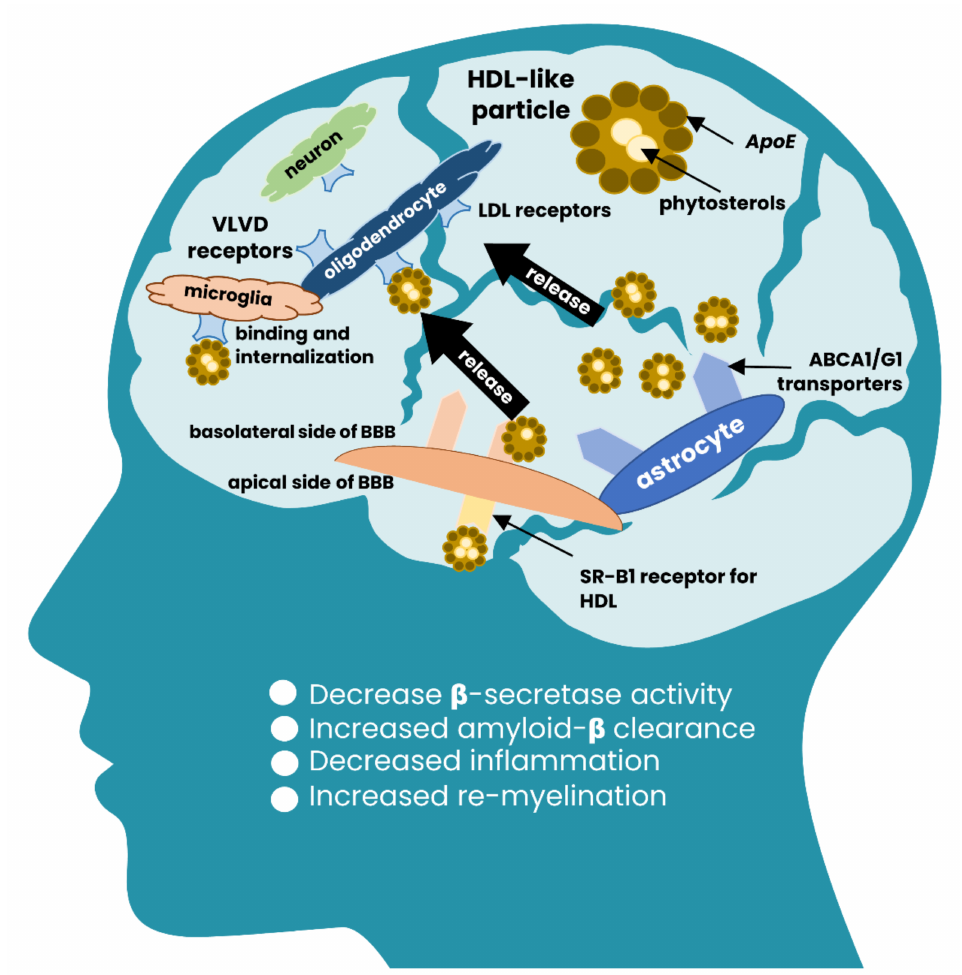
Figure 2. The proposed scheme of plant sterols entering the brain system. The mechanism involves HDL-like particles carrying plant sterols and apolipoprotein E (APOE). The HDL-like particles are translocated through SR-B1 HDL receptors on the apical side of the blood-brain barrier (BBB) and released into the brain via ABCA/ABCG1 transporters, which are expressed on the basolateral side of BBB and on the surface of astrocytes. LDL/VLDL receptors trap the released HDL-like particles enriched with plant sterols on the surface of microglia and oligodendrocytes since HDLs associated with APOE are the primary source of lipids transport in the central nervous system. Upon delivery, plant sterols activate mechanisms that decrease inflammation, increase amyloid- β clearance, and reduce the activity of β -secretase. The regulatory mechanism is largely unknown but is supposed to be realized through the activation of LXR/RXR receptors and regulation of APOE expression mediated by